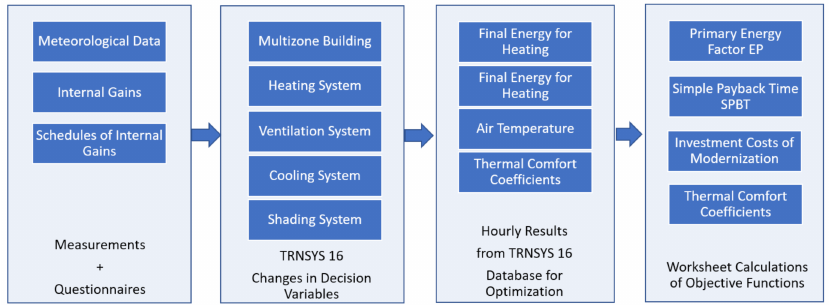
Figure 3. Objective functions—methodology of